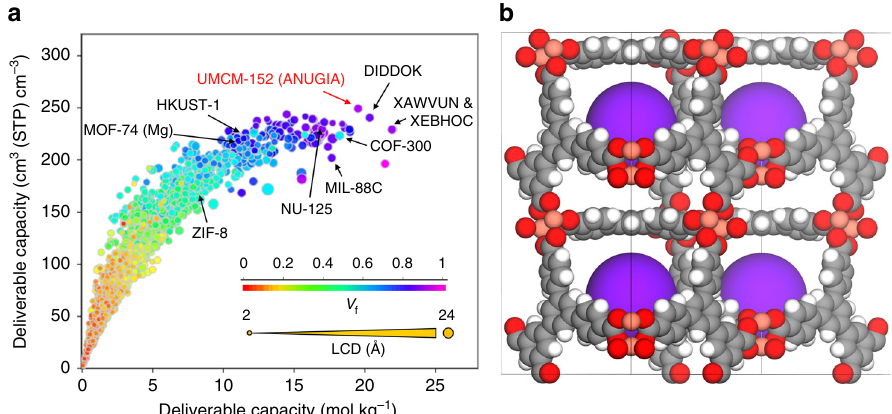
Fig. 2 Top-performing materials for oxygen storage. a Oxygen volumetric and gravimetric deliverable capacities (at 140 bar storage and 5 bar release pressures) for 2932 MOF structures at 298 K. Each point in the graph represents a different structure. The data points are color coded by void fraction ( V f ). Arrows represent common MOFs as well as promising materials identi fi ed in this work. b The crystal structure (super cell 2 × 2 × 1) for the top material identi fi ed for volumetric oxygen storage, UMCM-152. Main cavity is represented by purple sphere